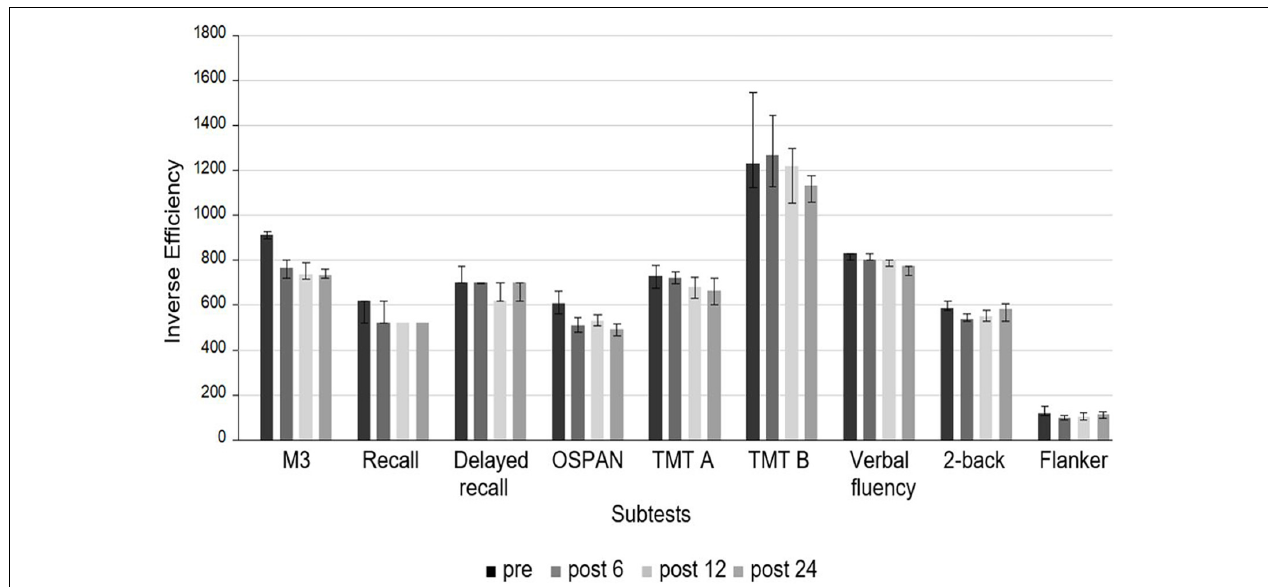
FIGURE 1 | Median of the IE of the neurocognitive subtests at different times (preoperatively, 6, 12, and 24 months after cochlear implantation). A lower IE score indicates a better performance. None of the subtest scores improved between 12 and 24 months after cochlear implantation.